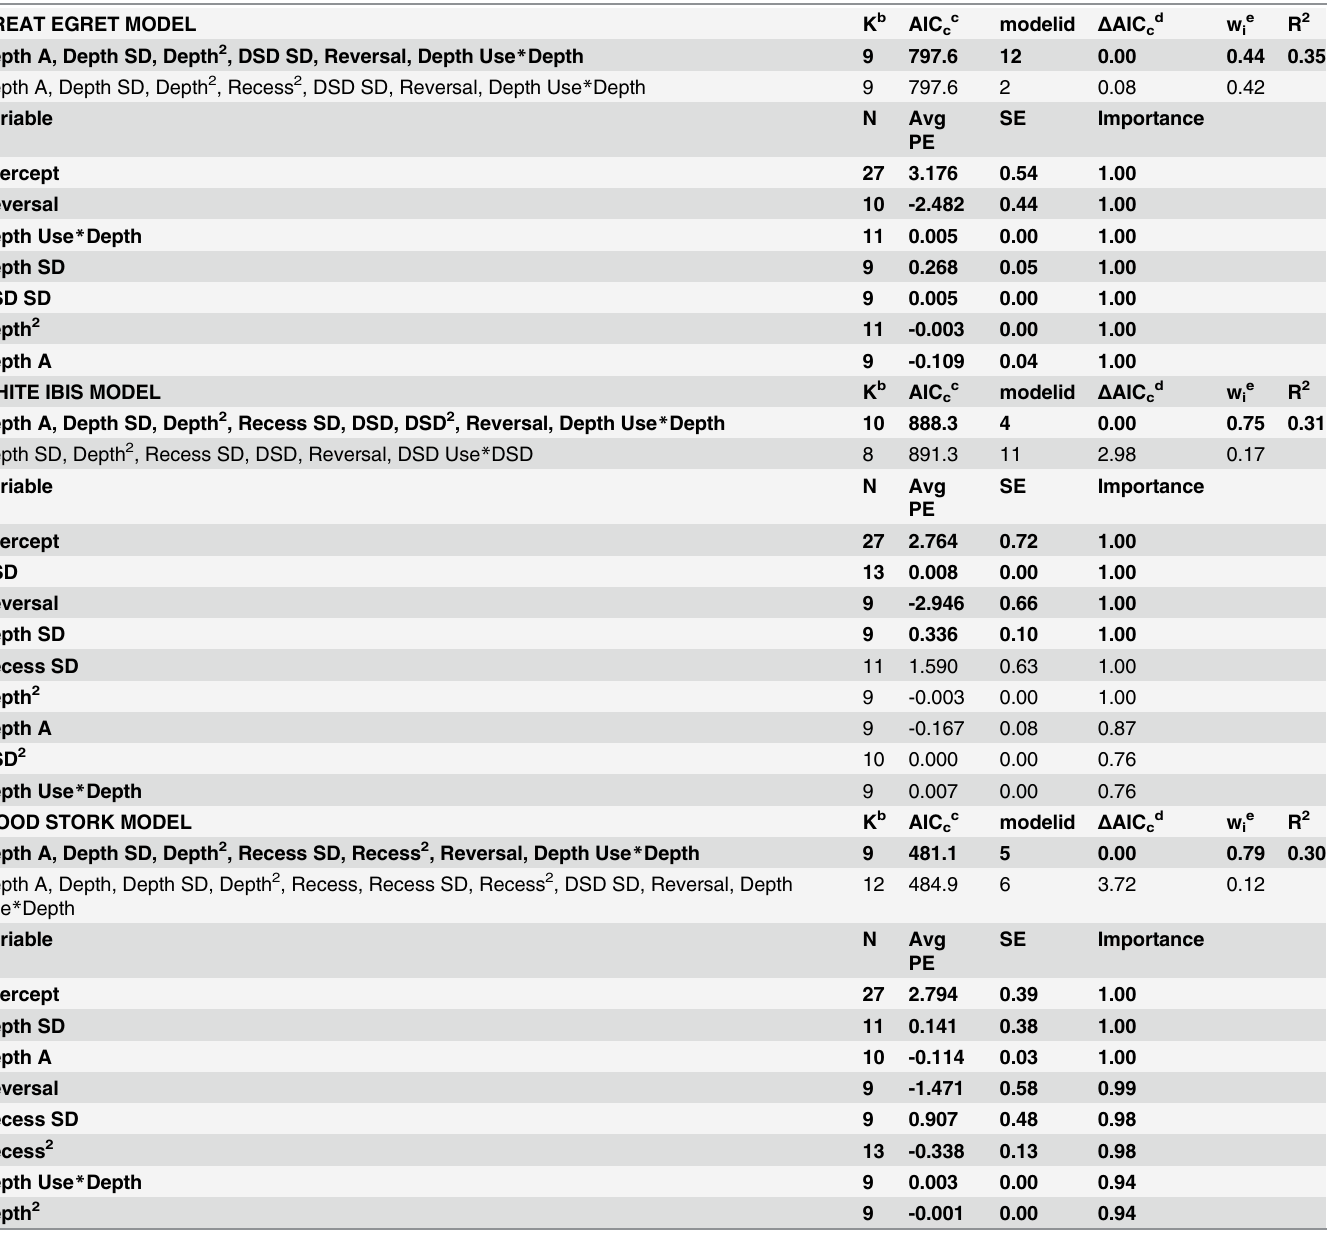
Table 5. Ranking of candidate models describing variables influencing daily individual abundance of Great Egrets, White Ibises, and Wood Storks in the Florida Everglades (Proc Mixed). GREAT EGRET MODEL